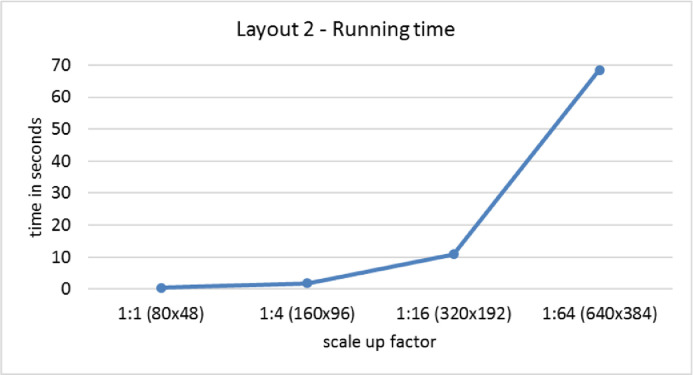
BBCD running time.